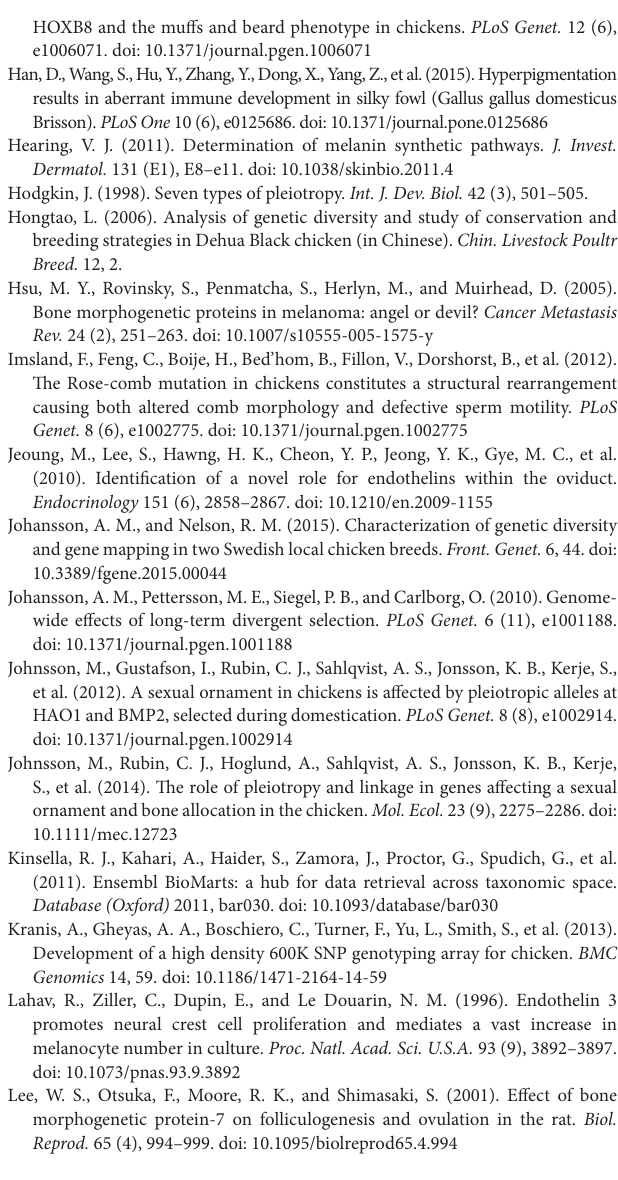
SUPPLEMENTARY FIGURE 2 | Tissue distribution of melanin in Dongxiang blue-shelled chicken. Comb tissues from RCL (A, C) and DCL (B, D) (A and B with scale bar = 200 μm, C and D with scale bar = 50 μm.). Melanin was distributed in the tissue of DCL whereas it was absent in RCL. Hematoxylin and eosin staining. SUPPLEMENTARY FIGURE 3 | Summary of outlier SNPs and genes from the identification of signature of selection. (A) Distribution of outliers in the gene structure detected by the FST and XP-EHH tests. Overlaps of outlier SNPs (B) and genes (C) detected by the FST and XP-EHH tests. SUPPLEMENTARY FIGURE 4 | Gene enrichment analysis. (A) The category clusters from XP-EHH test. (B) The category clusters from FST test. SUPPLEMENTARY FIGURE 5 | Diagnostic test of boundaries of both the duplicated regions. The dark comb chickens displayed two bands in the agarose gel indicating the duplications in the genome, whereas the red comb chickens without the variant of genomic structure showed one band in the